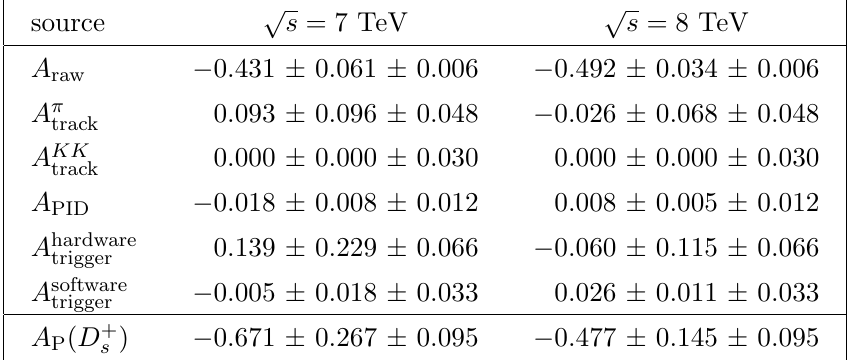
Table 1 . Raw and detection asymmetries in percent, for the 7 and 8 TeV data sets. The detection asymmetries are determined on the data combined from all kinematic bins. The (cid:12)rst uncertainty is statistical, the second